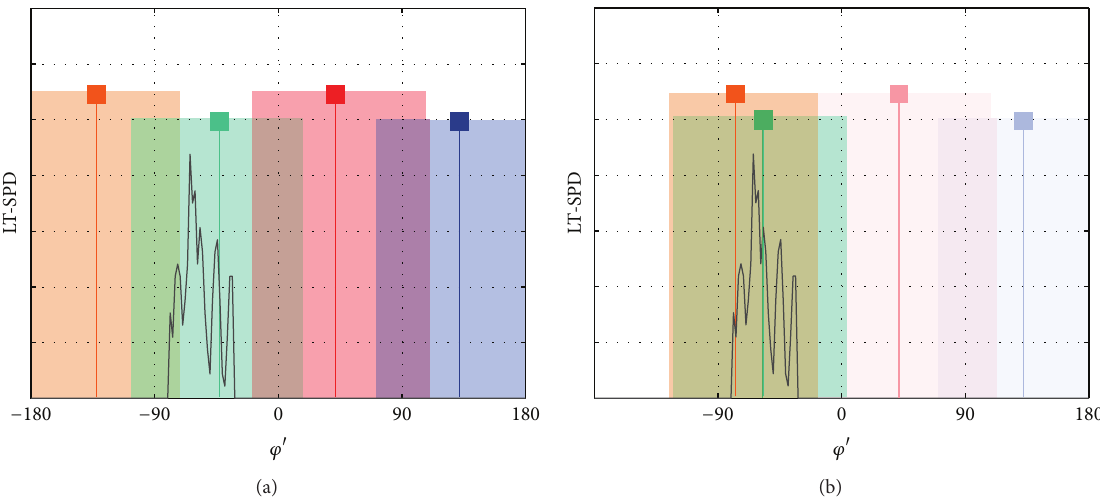
Figure 4: Modified k -means clustering algorithm. (a) Initial step with 𝑄 = 4 . The colored shades represent the areas in which the local COGs are determined. (b) Result after the first assignment